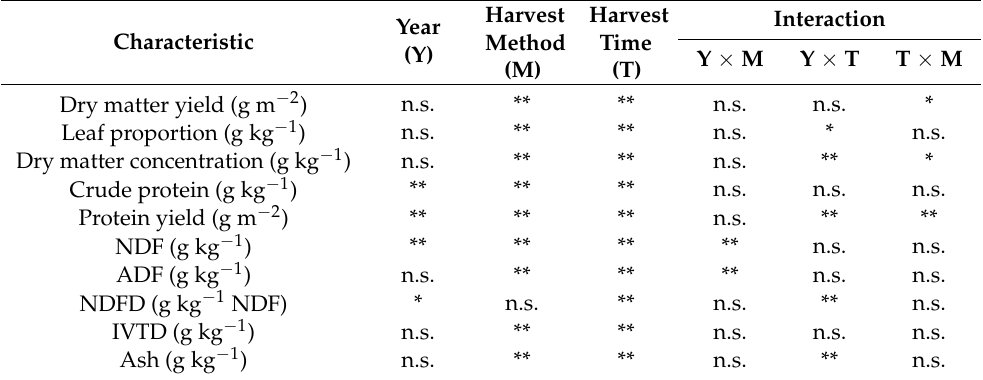
Table 2. Analysis of variance of the characteristics studied as a function of year, harvest time, and harvest method.